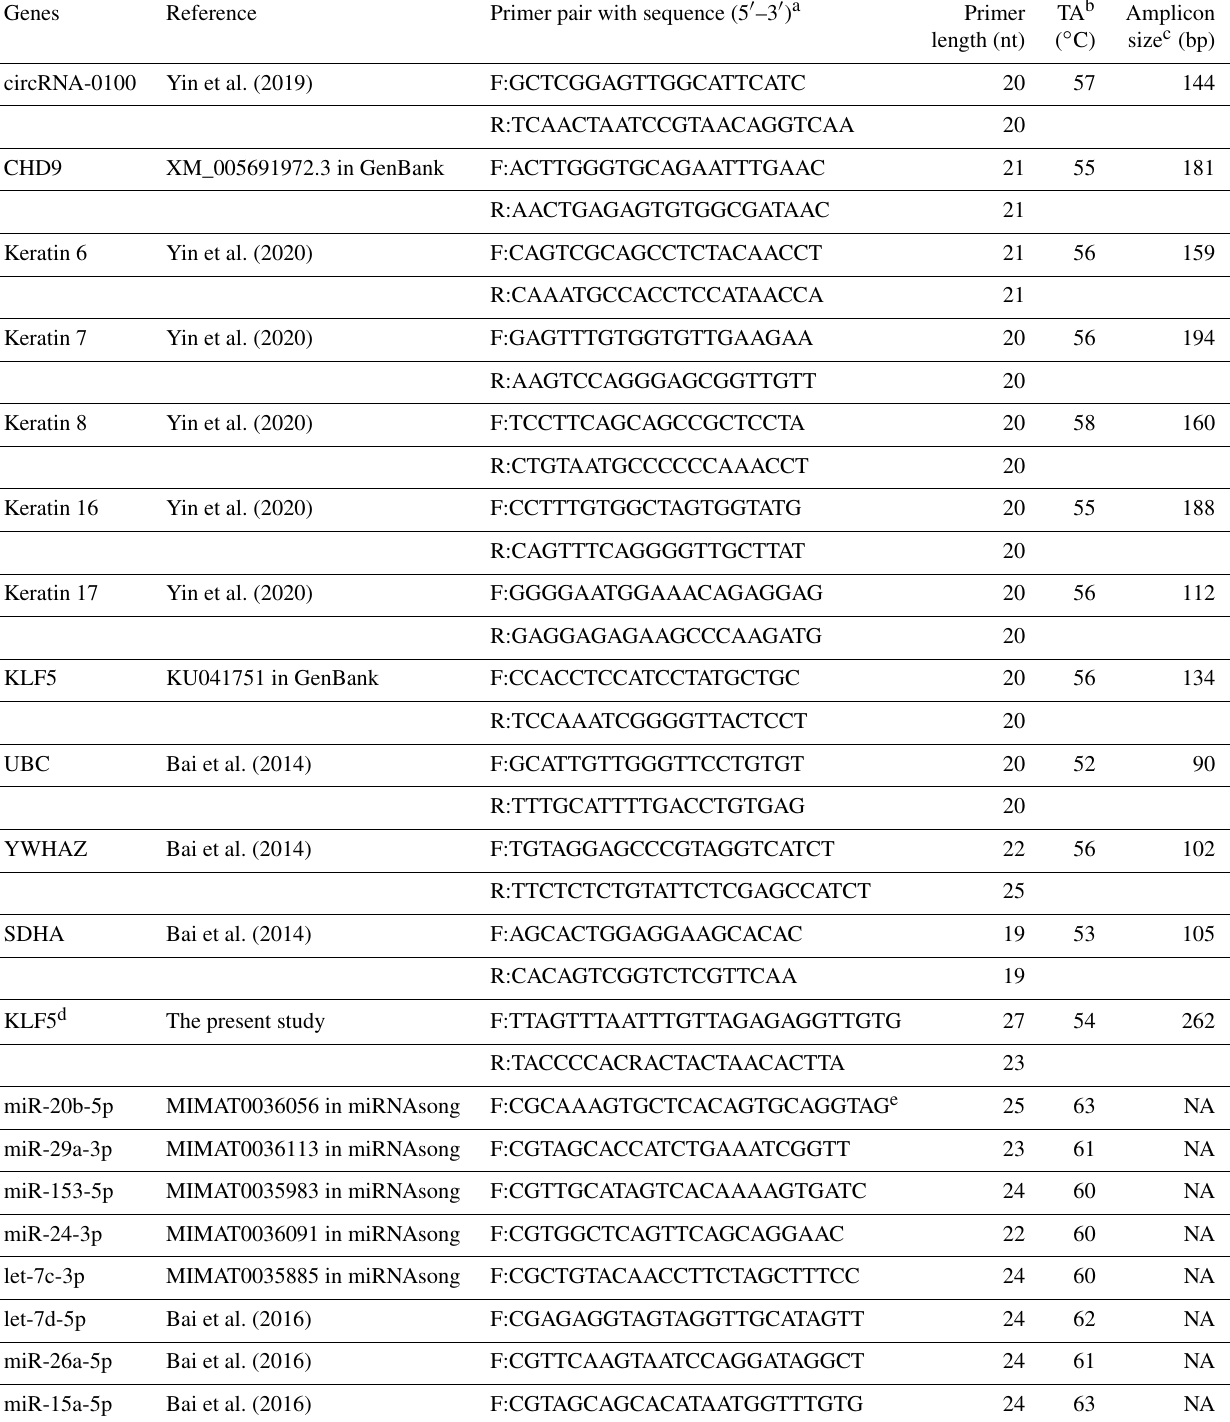
Table 1. Detail of PCR primers utilized in this study along with the corresponding annealing temperature for PCR amplification.